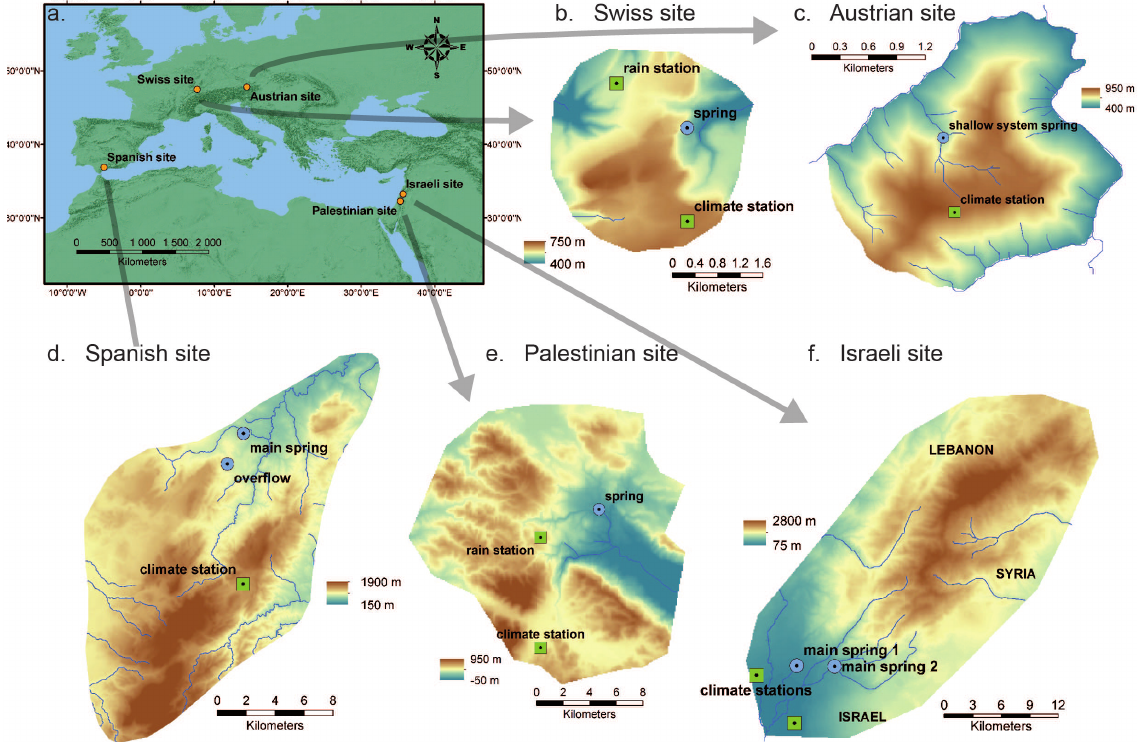
Fig. 1. (a) Location and (b) – (f) maps of the study sites in Europe and the Middle East.